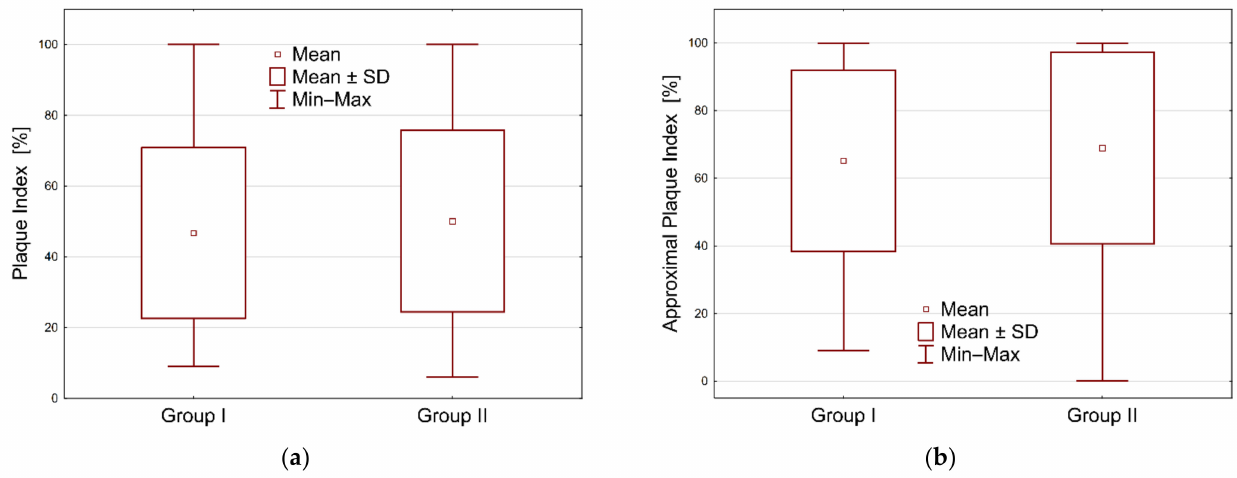
Figure 3. Graphical representation of indices through boxplots in two groups: ( a ) plaque index, ( b ) approximal plaque